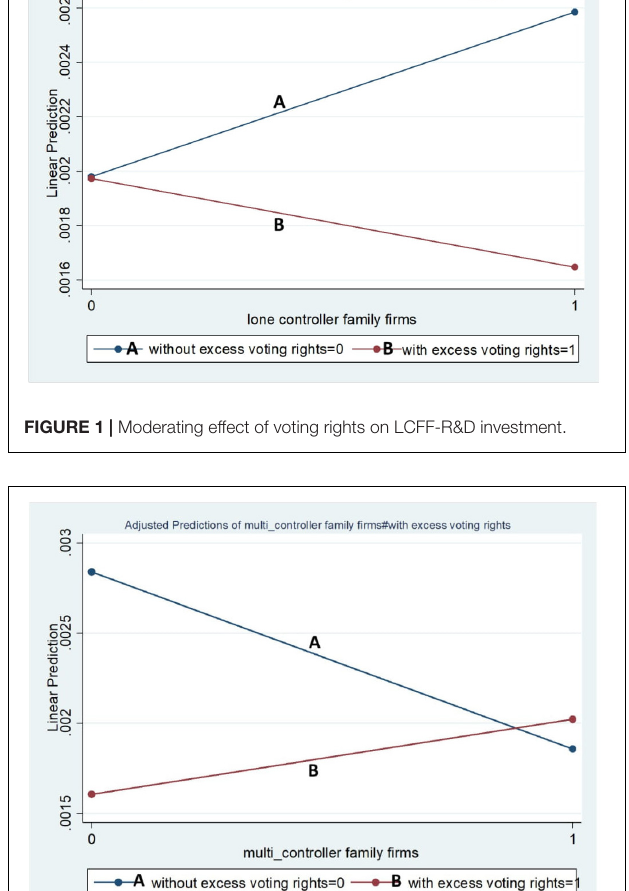
TABLE 7 | Robust regression results with the Tobit model by using dummy moderating